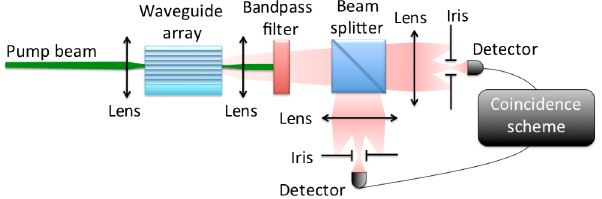
FIG. 5. Schematic illustration of the experimental setup for the SPDC photon-pair correlation measurements.